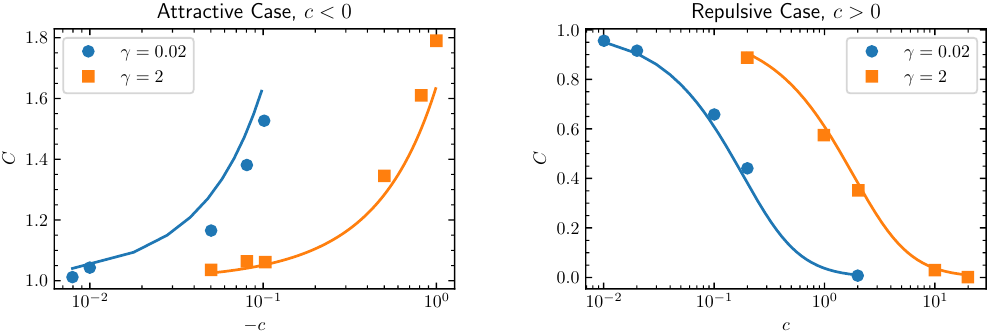
Figure 5: Comparison of the mean-field contact parameter from Eq. (30) to the Quantum Monte-Carlo result [ 12 ] for two different boson-boson interaction strengths γ = 0.02 (blue circles) and γ = 2 (orange squares). The results are shown as a func- tion of the impurity-boson interaction strength, c with c < 0 [ c > 0 ] displayed in the left [ right ] panels, respectively. The solid curves give the mean-field results, while the circles / squares are from Ref. [ 12 ] . The masses of the impurity and the bosons are equal ( m =